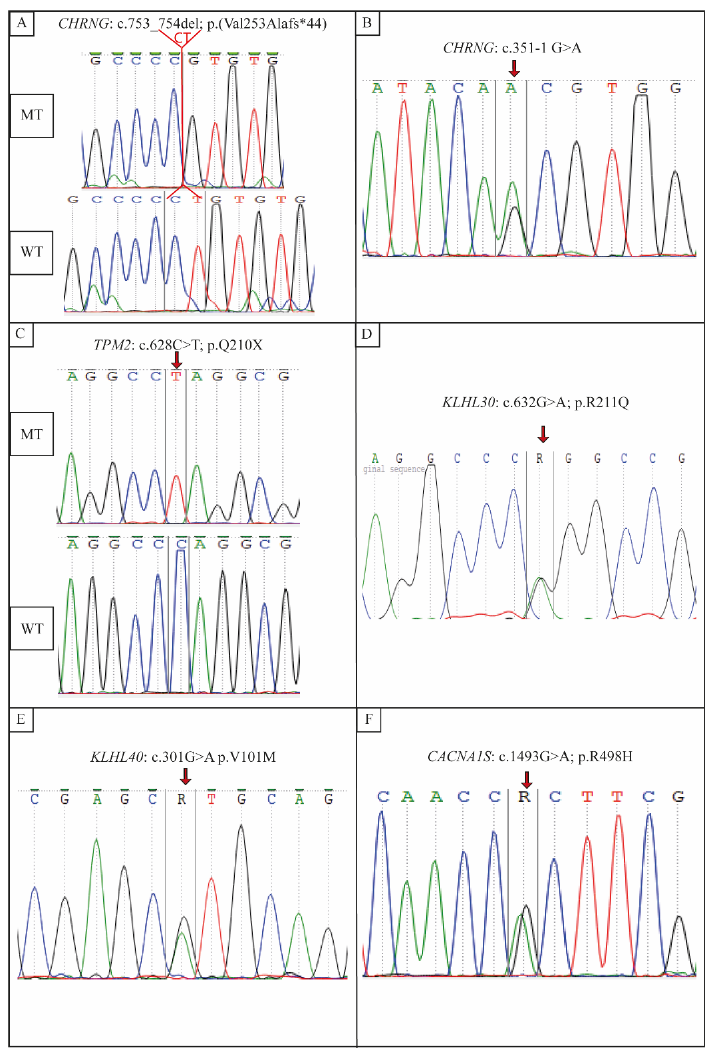
Figure 3. Electropherograms showing genetic particularities in Tunisian Escobar patients: ( A ) mu- tation in CHRNG gene, at a homozygous state in Patients 4 and 5; ( B ) mutation in CHRNG gene, at a heterozygous state in Patient 1 and her mother; ( C ) mutation in TPM2 gene, at a homozygous state in Patients 2 and 3; ( D ) mutation in KLHL30 gene, at a heterozygous state in Patients 2 and 3; ( E ) mutation in KLHL40 gene, at a homozygous state in Patients 2 and 3; ( F ) mutation in CACNA1S gene, at a heterozygous state in Patient 3.